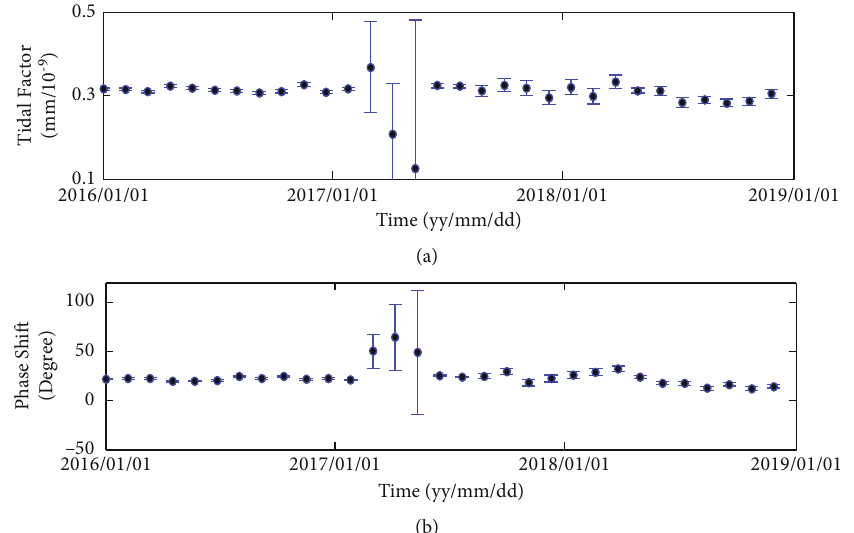
2 Earth tide from 2016/01/01 to 2018/12/31, where the blue error